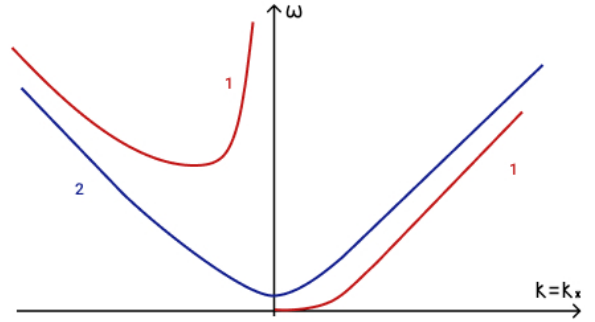
Figure 8. Dispersion curves for 1—magneto-Rossby wave ω mr 1 and 2—magnetogravity wave ω mgr